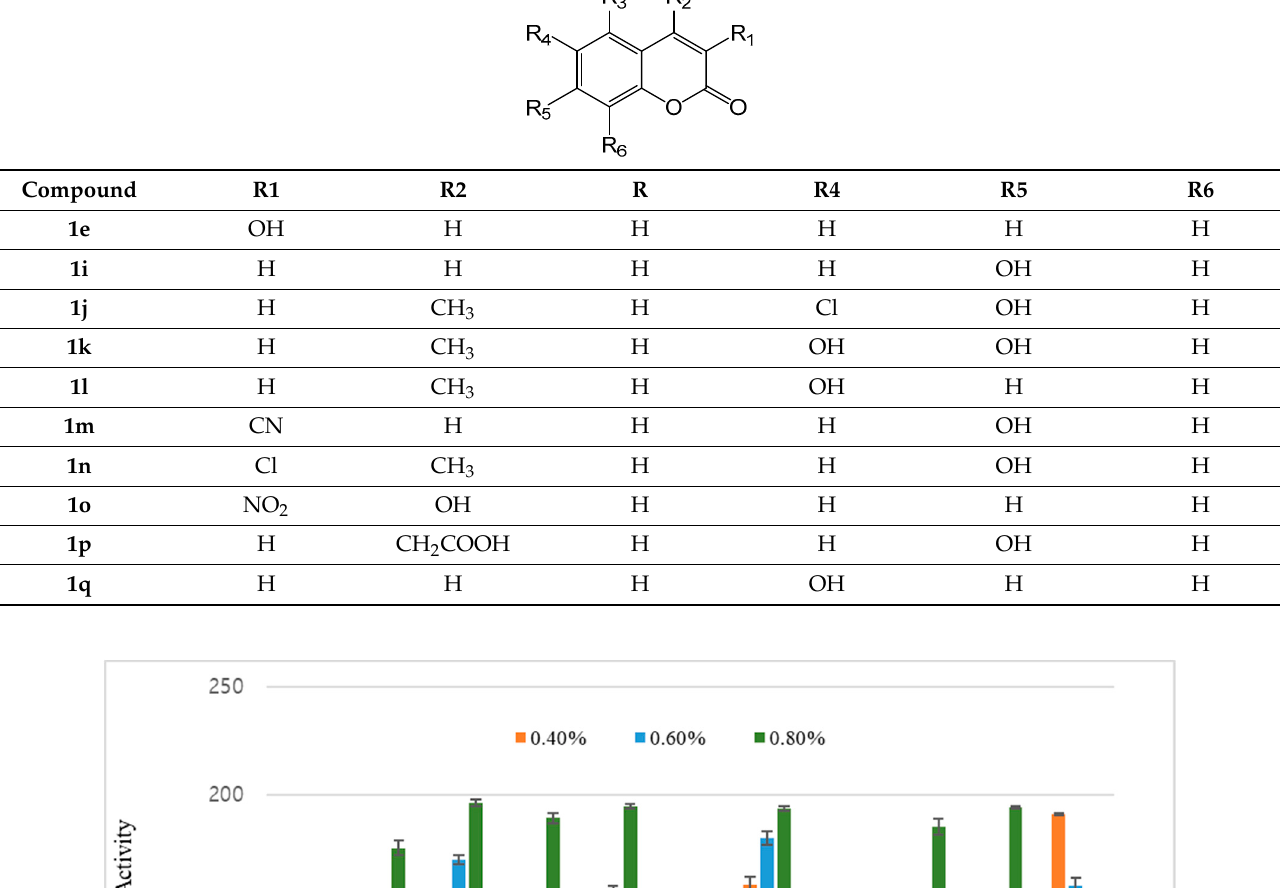
Table 2. Hydroxycoumarin derivatives with functional groups in several positions 1e – 1q.